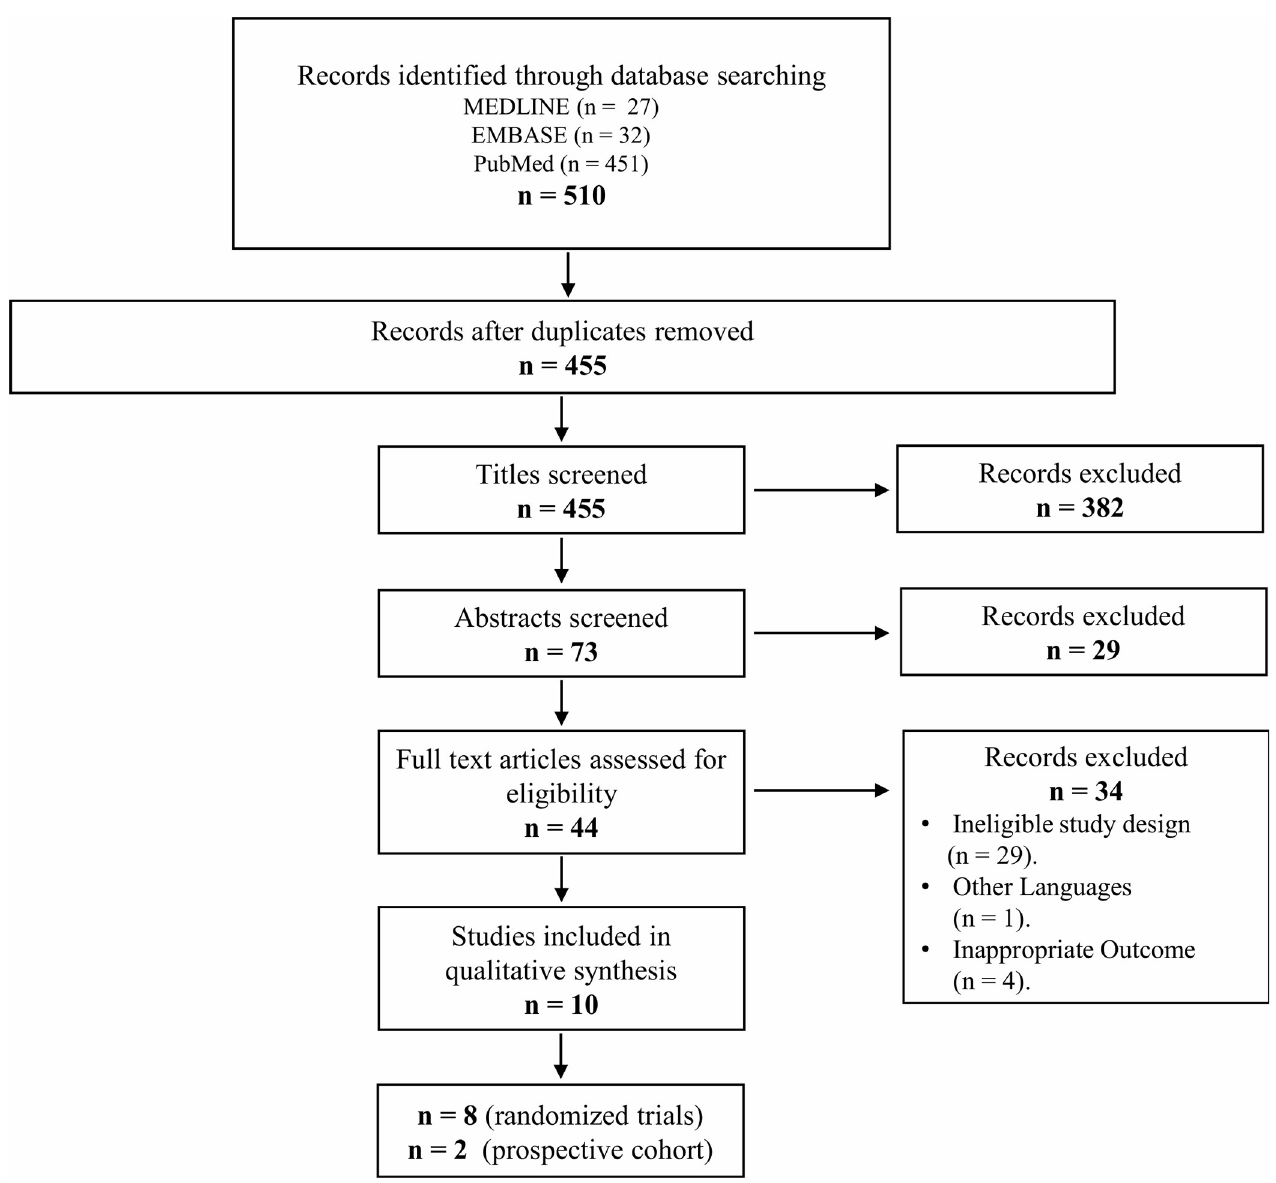
Fig 1. Selection of studies for inclusion in the systematic